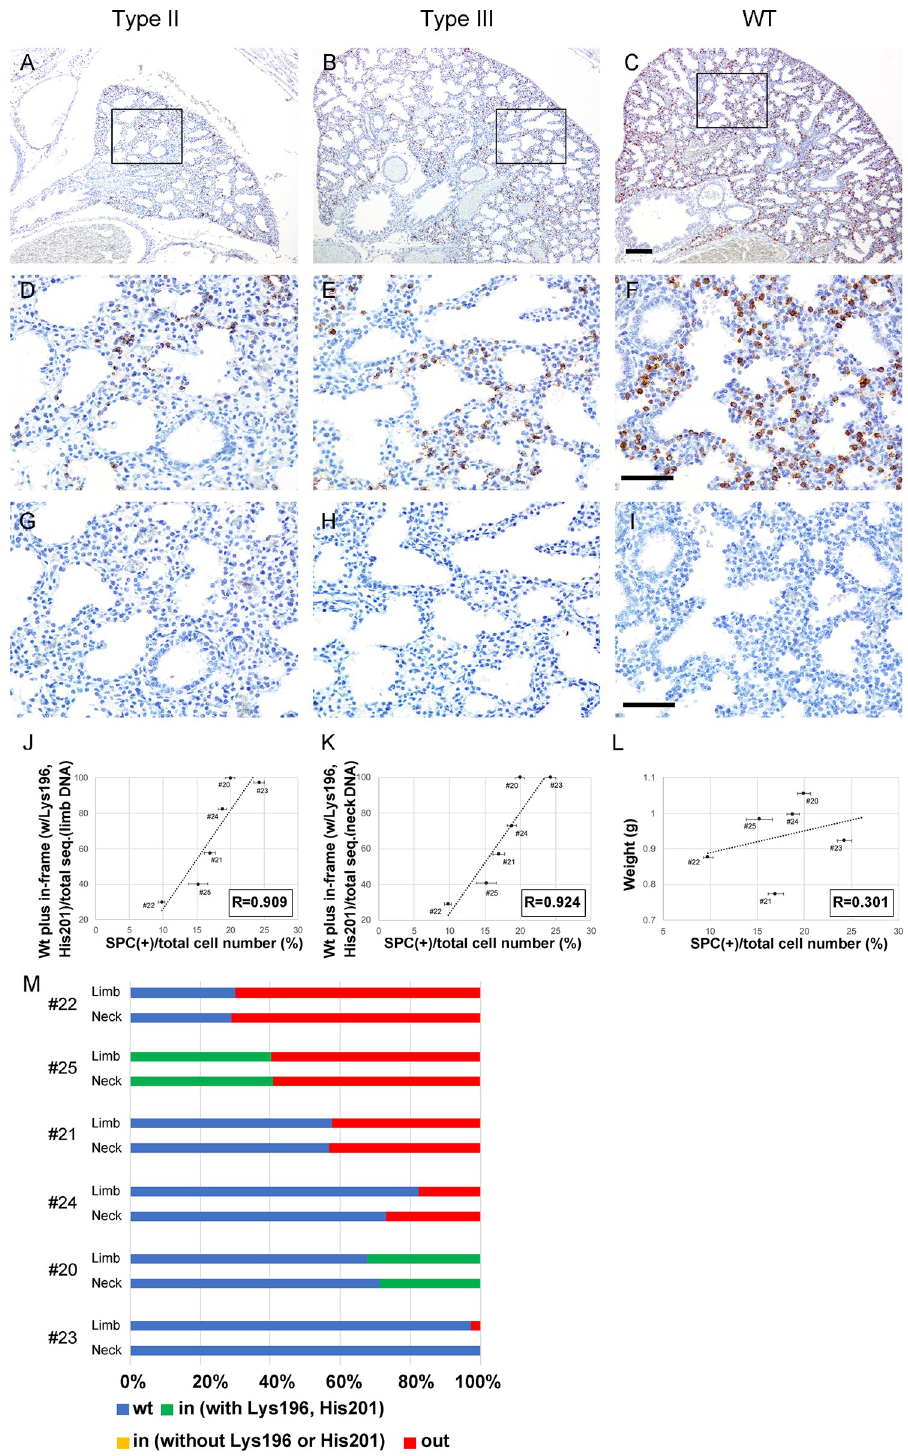
Fig 6. Immunohistochemistry of the lung in type II and type III Fgf10 -crispants and wild type embryos at E18.5. Representative data are shown. Nuclei are stained with Hematoxylin. A-C , Localization of Surfactant protein C (SPC) (alveolar type 2 epithelial cells) is indicated by brown staining. D-F , close-up of the boxed area shown in ( A–C ), respectively. G-I , negative control, using normal rabbit IgG instead of anti-SPC antibody. Scale bars: 100 μ m in ( A-C ); 50 μ m in ( D-I ). J, K , the number of SPC-positive cells in type III embryos is correlated to the percentage of functional